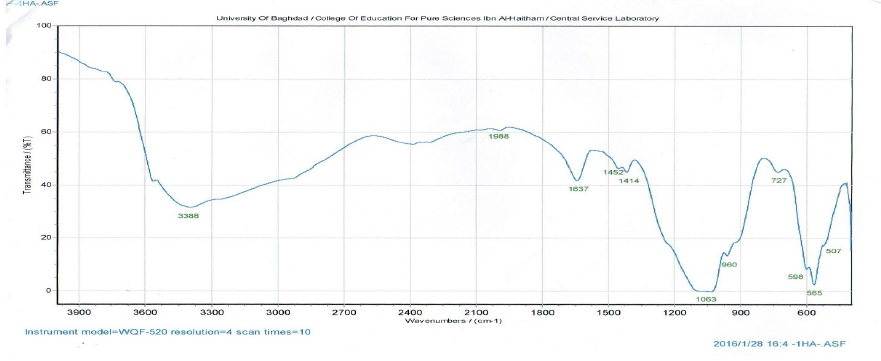
(figure3): FTIR of nano